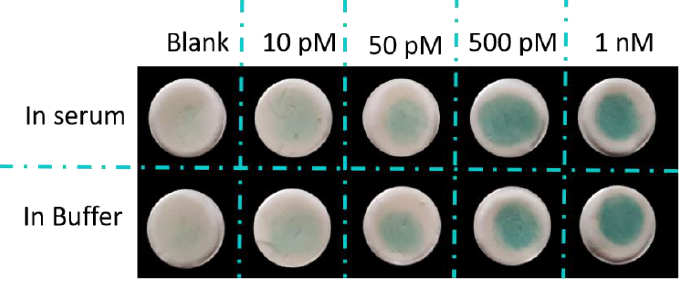
Figure 6. miRNA-21 detection in human serum samples and in PBS at different concentrations. Table 3. Results of miRNA-21 detection in human serum samples using the suggested genosensor (n = 3).